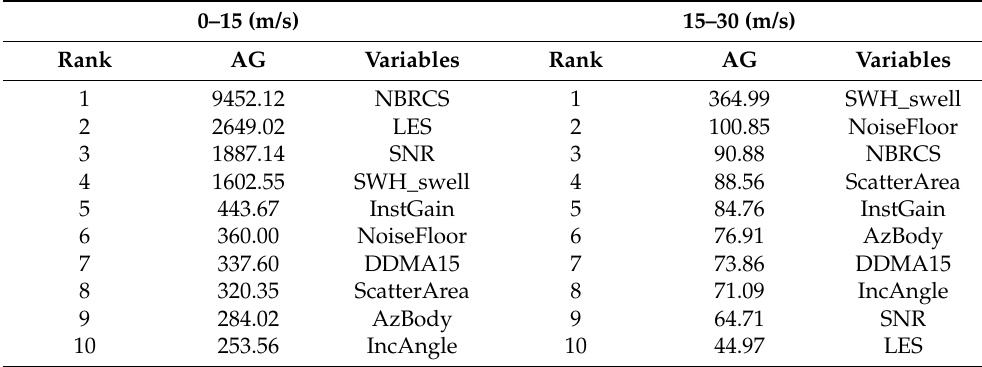
Table 9. Rankings of the effects of